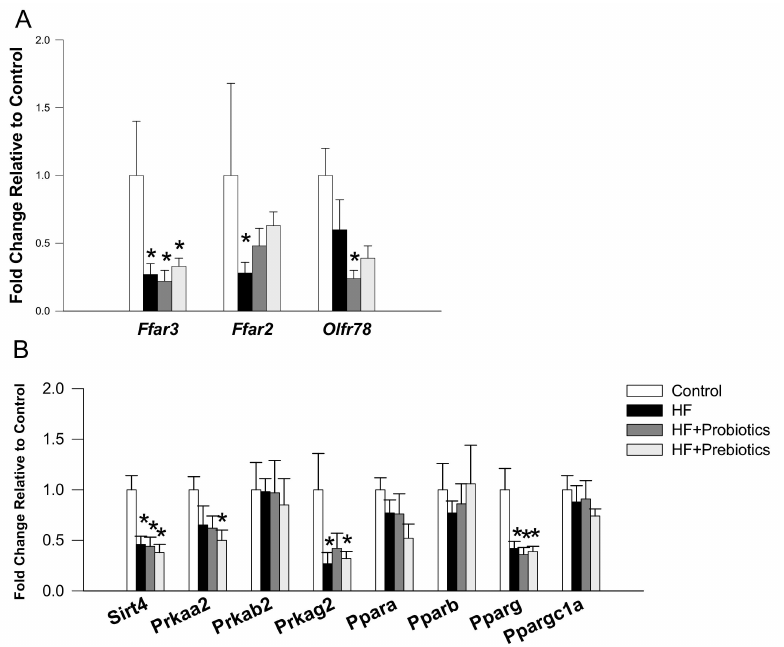
Figure 2. Effect of maternal high-fructose (HF) diet, probiotic Lactobacillus casei , and prebiotic inulin